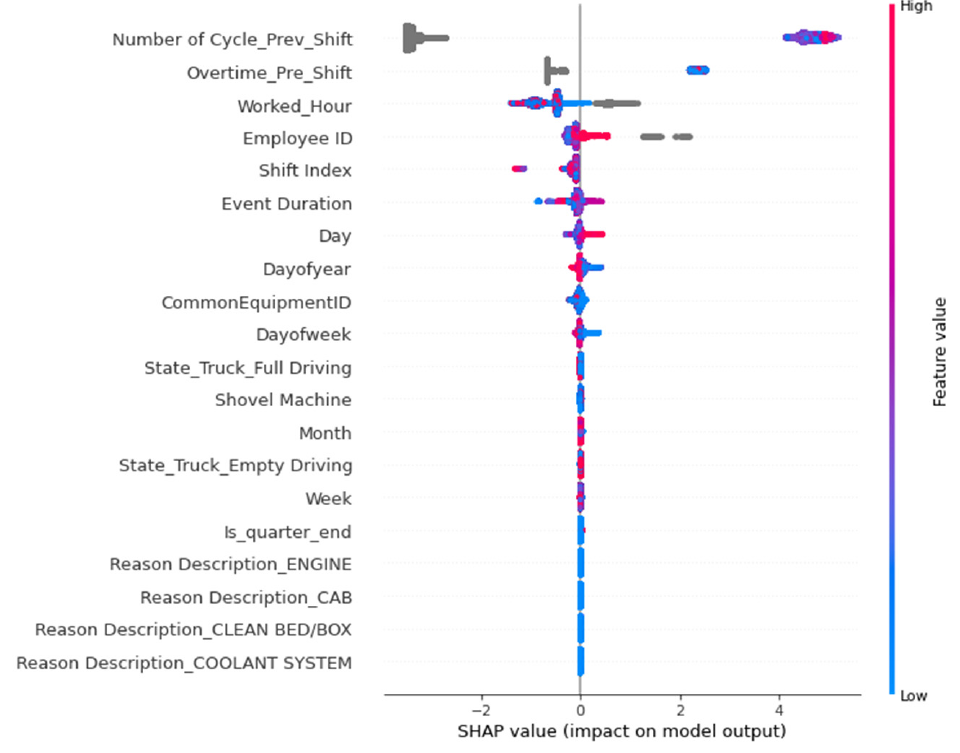
Figure 10. SHAP value of the first model.